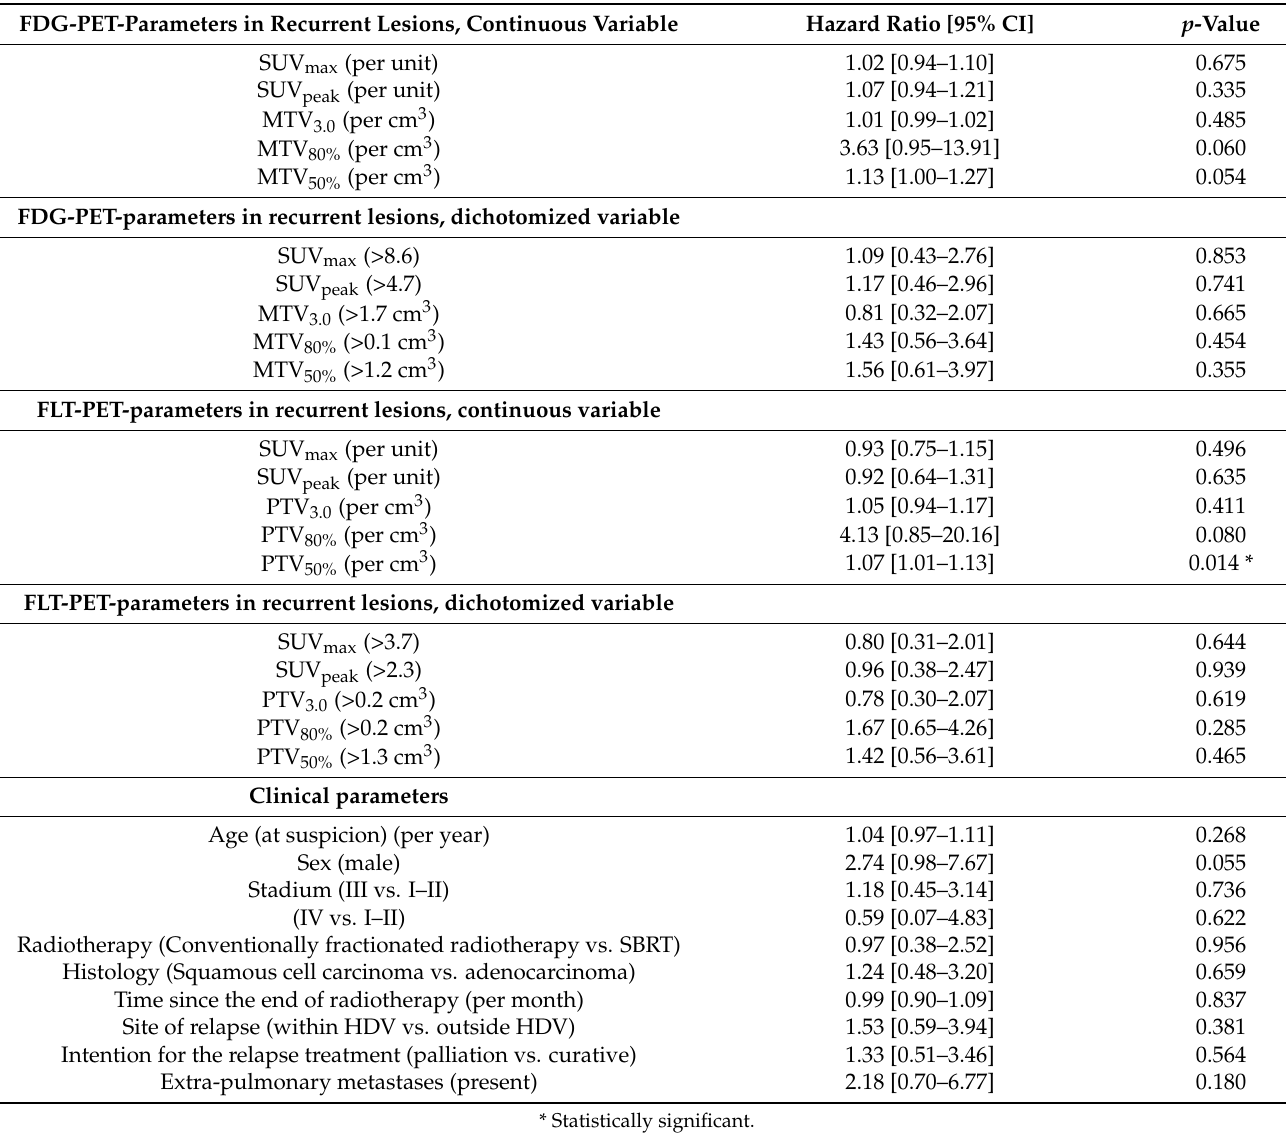
Table 3. Prognostic value of PET-parameters and clinical variables in patients with relapsed lung cancer ( n = 30). Univariate survival